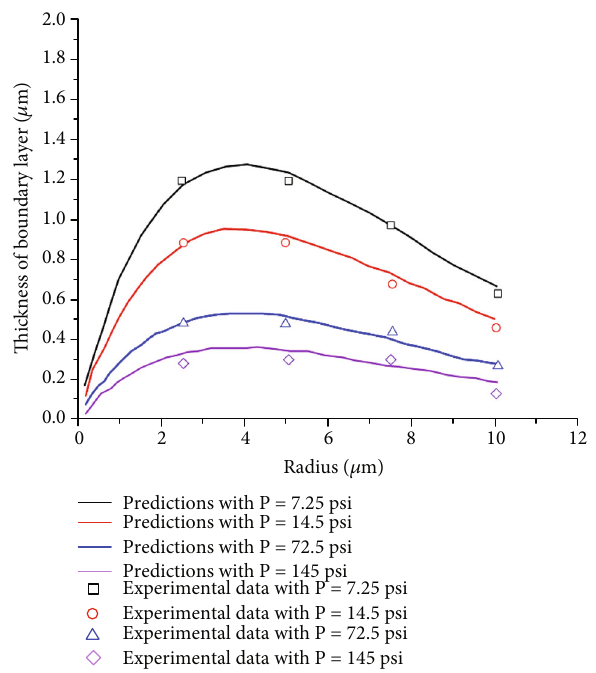
Figure 1: A comparison between calculation results of BL thickness using Equation (1) and microtube experimental results (reproduced from